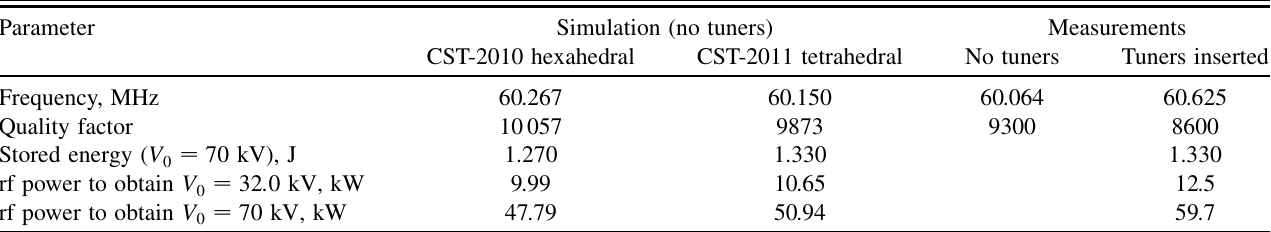
TABLE II. Comparison of the simulated and measured parameters of the RFQ resonator. The design simulations were originally done in 2010 using the hexahedral mesh option in MW-STUDIO . In 2011, the tetrahedral mesh option became available and repeated simulations led to new results that were different from the original simulations but much closer to the measured data.